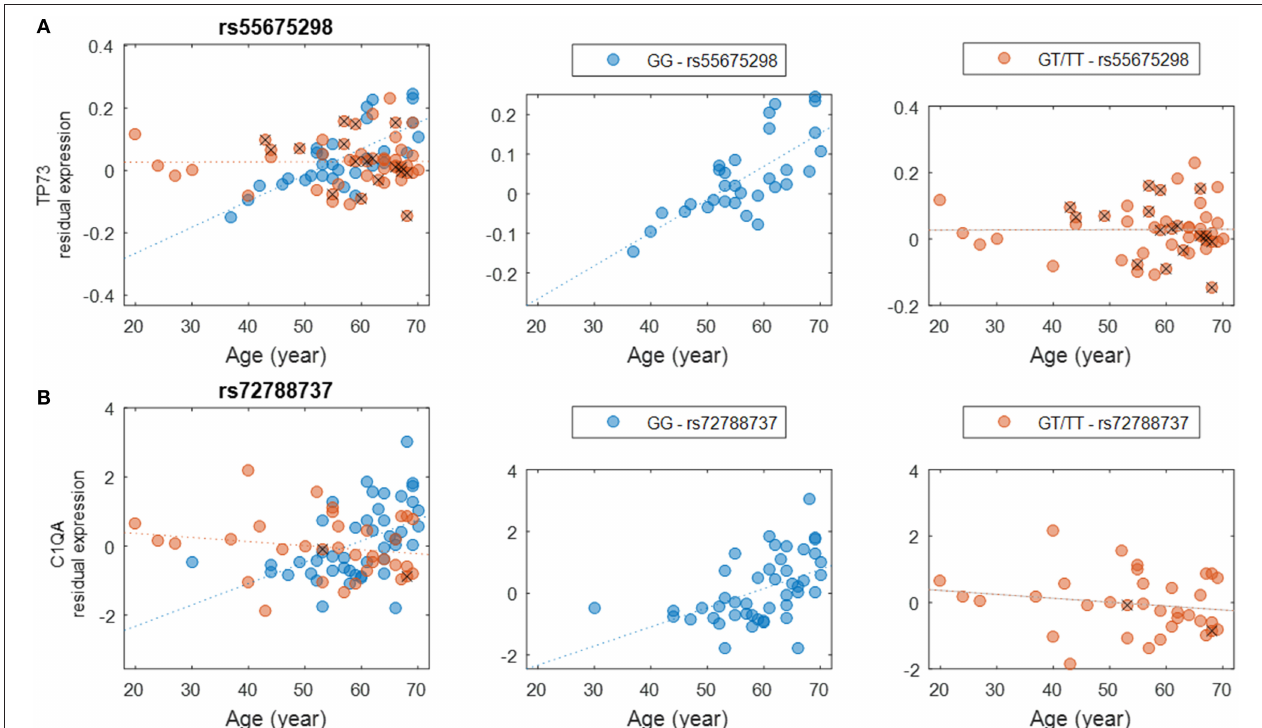
FIGURE 3 | Examples of genotype-by-age interaction affecting the expression level of the gene. (A) The interaction between rs55675298 and age affecting TP73 gene expression. (B) The interaction between rs72788737 and age affecting C1QA gene expression. For each subplot, the left panel shows all samples, the middle panel shows the major allele homozygous samples, and the right panel shows heterozygous and minor allele homozygous (with a cross)